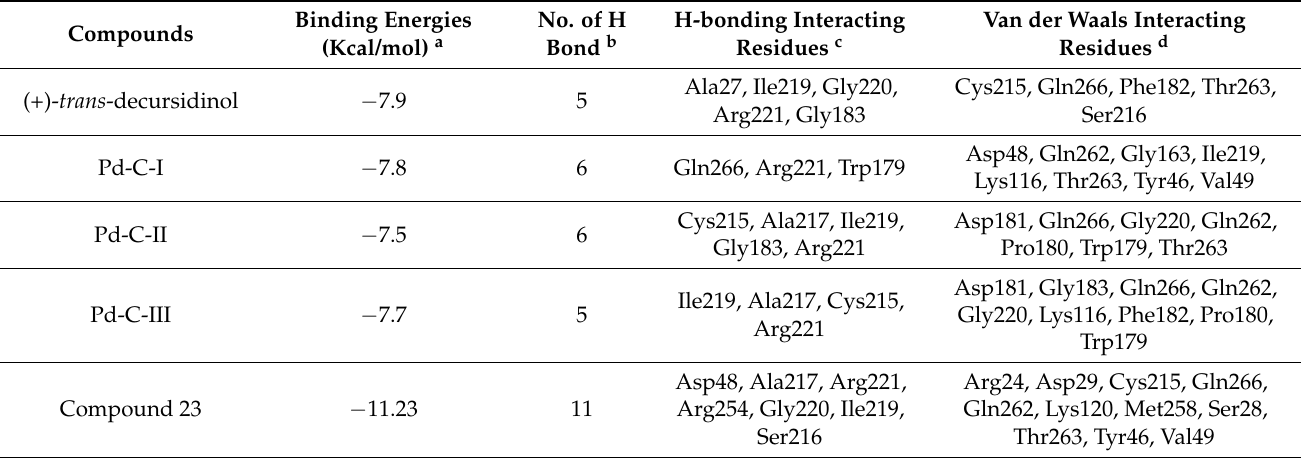
Table 2. Molecular interaction of the protein tyrosine phosphatase 1B (PTP1B) active site with dihydroxanthyletin-type coumarins, as well as reference inhibitor.